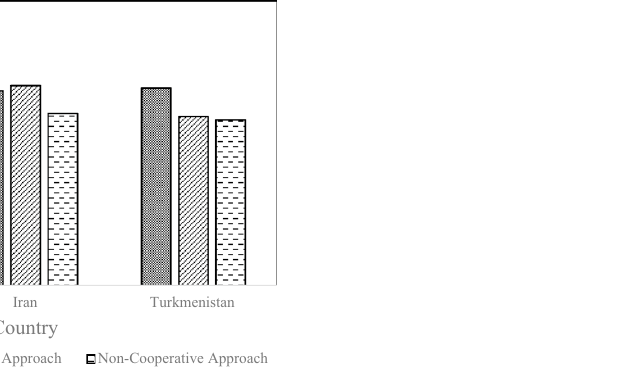
Figure 9. Agricultural stress criteria for each